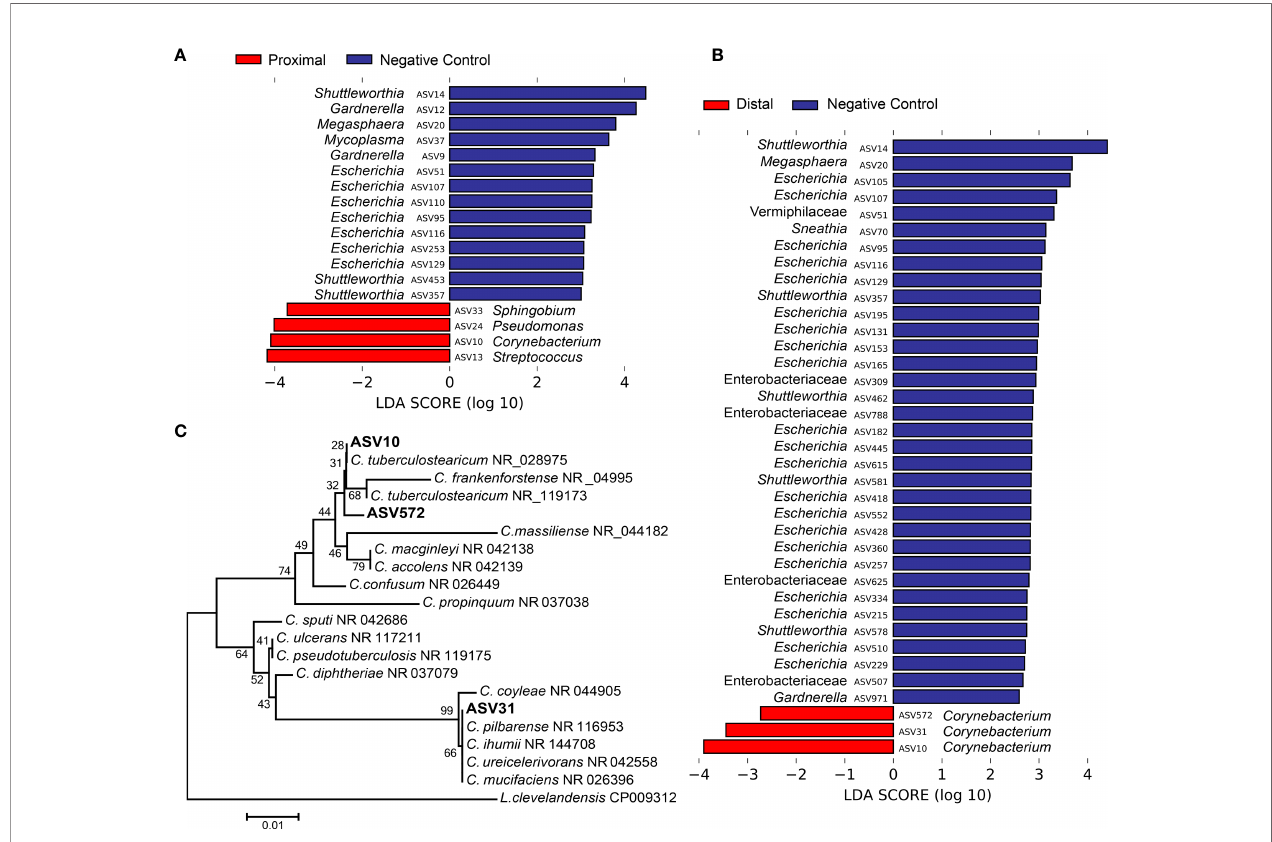
FIGURE 3 | Differentially abundant amplicon sequence variants (ASVs) in proximal and distal amniotic fl uid and blank control samples. (A) proximal and (B) distal amniotic fl uid samples compared to blank DNA extraction controls as determined by Linear discriminant analysis effect size analyses. (C) Dendrogram of the three differentially abundant Corynebacterium ASVs in amniotic fl uid samples and partial 16S rRNA gene sequences of closely related bacterial type strains. Numbers at the nodes are maximum-likelihood bootstrap values. Scale bar indicates the number of nucleotide substitutions per